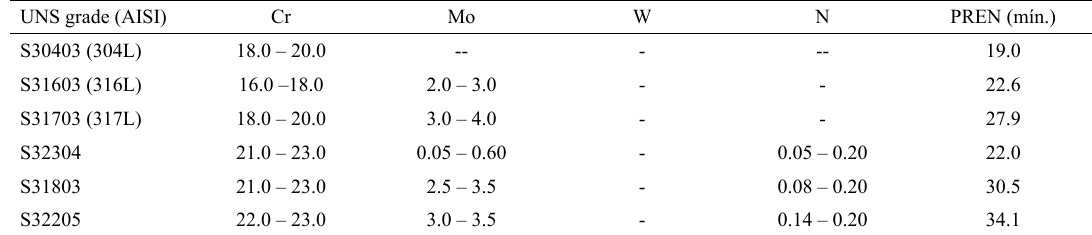
Table 1: Cr, N, W and Mo contents specified and minimum PRE values for grades UNS S30403, S31603, S31703, S32304, S31803, and S32205 (%wt.). 4 UNS grade (AISI) Cr Mo W N PREN (mín.) S30403